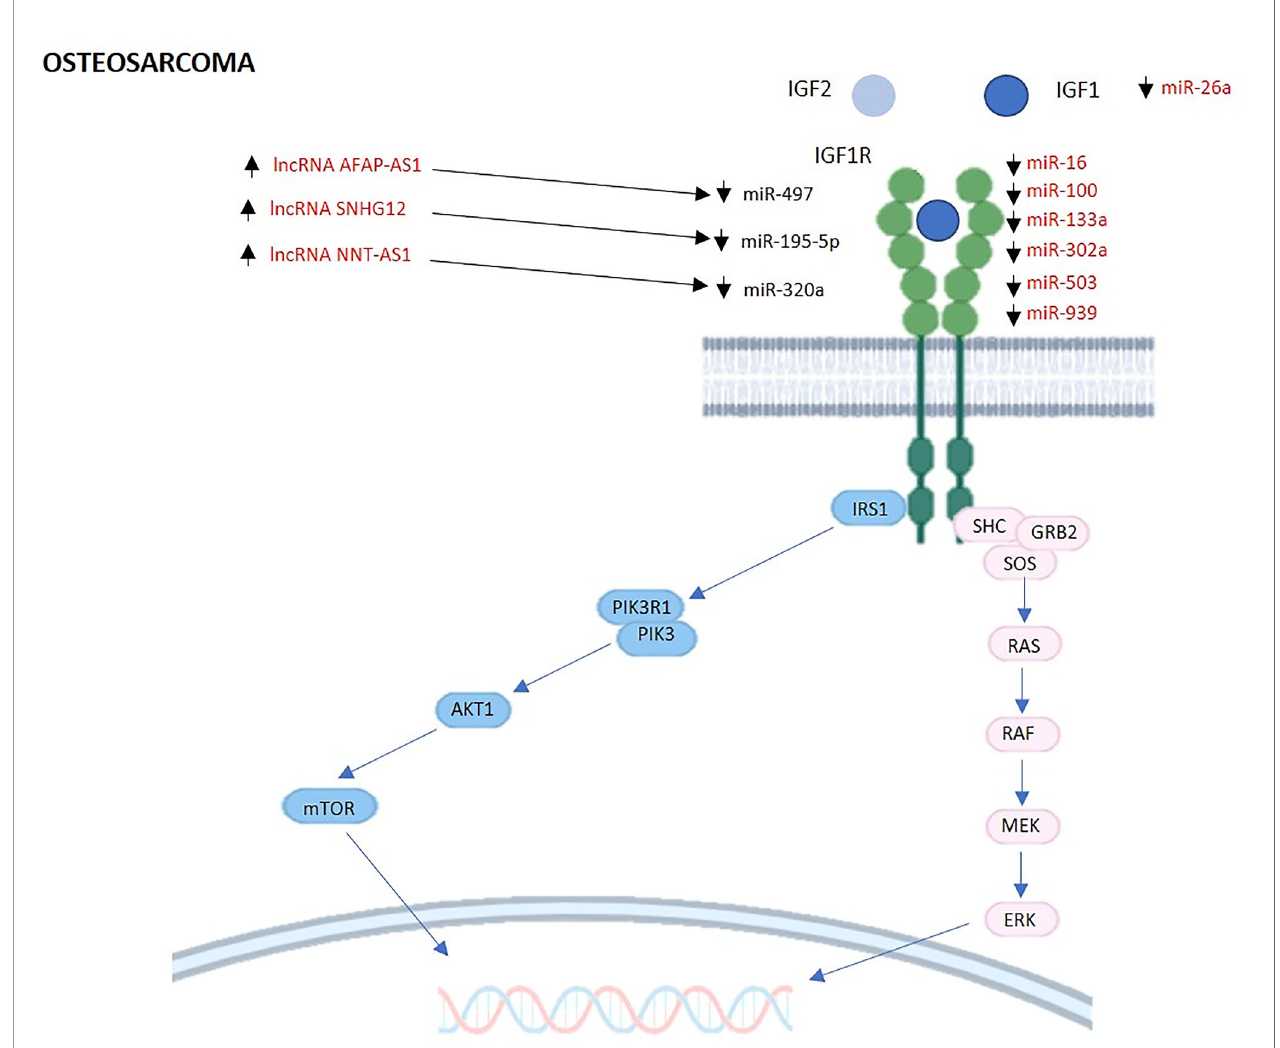
FIGURE 2 | MiRNAs and lncRNAs regulating IGF signaling in osteosarcoma. The schematic cartoon describes current knowledge relative to the interactions among miRNAs, lncRNAs and their targets within the IGF1 signaling pathways in the context of osteosarcoma. The miRNAs and lncRNAs known to interact directly with their targets are reported in red. IGF1, Insulin Like Growth Factor 1; IGF2, Insulin Like Growth Factor 2; IGF1R, Insulin Like Growth Factor 1 Receptor; IRS1, Insulin Receptor Substrate 1; PIK3R1, Phosphoinositide-3-Kinase Regulatory Subunit 1; PIK3, phosphoinositide 3-kinase; AKT1, AKT Serine/Threonine Kinase 1; mTOR, mammalian target of rapamycin; SHC, Src Homology 2 Domain-Containing protein; GRB2, Growth Factor Receptor Bound Protein 2; SOS, Son of sevenless Ras/ Rac Guanine Nucleotide Exchange Factor; RAS, rat sarcoma protein; RAF, Raf Proto-Oncogene, Serine/Threonine Kinase; MEK, Mitogen-Activated Protein Kinase Kinase; ERK, extracellular signal-regulated